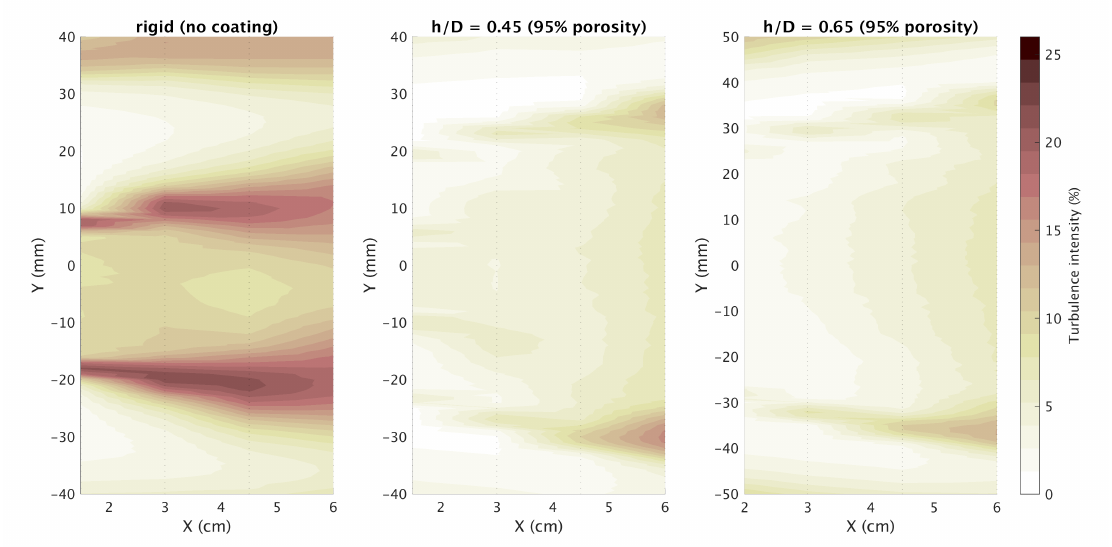
Figure 16. Contour plot of turbulence intensity for cylinders 1, 10, and